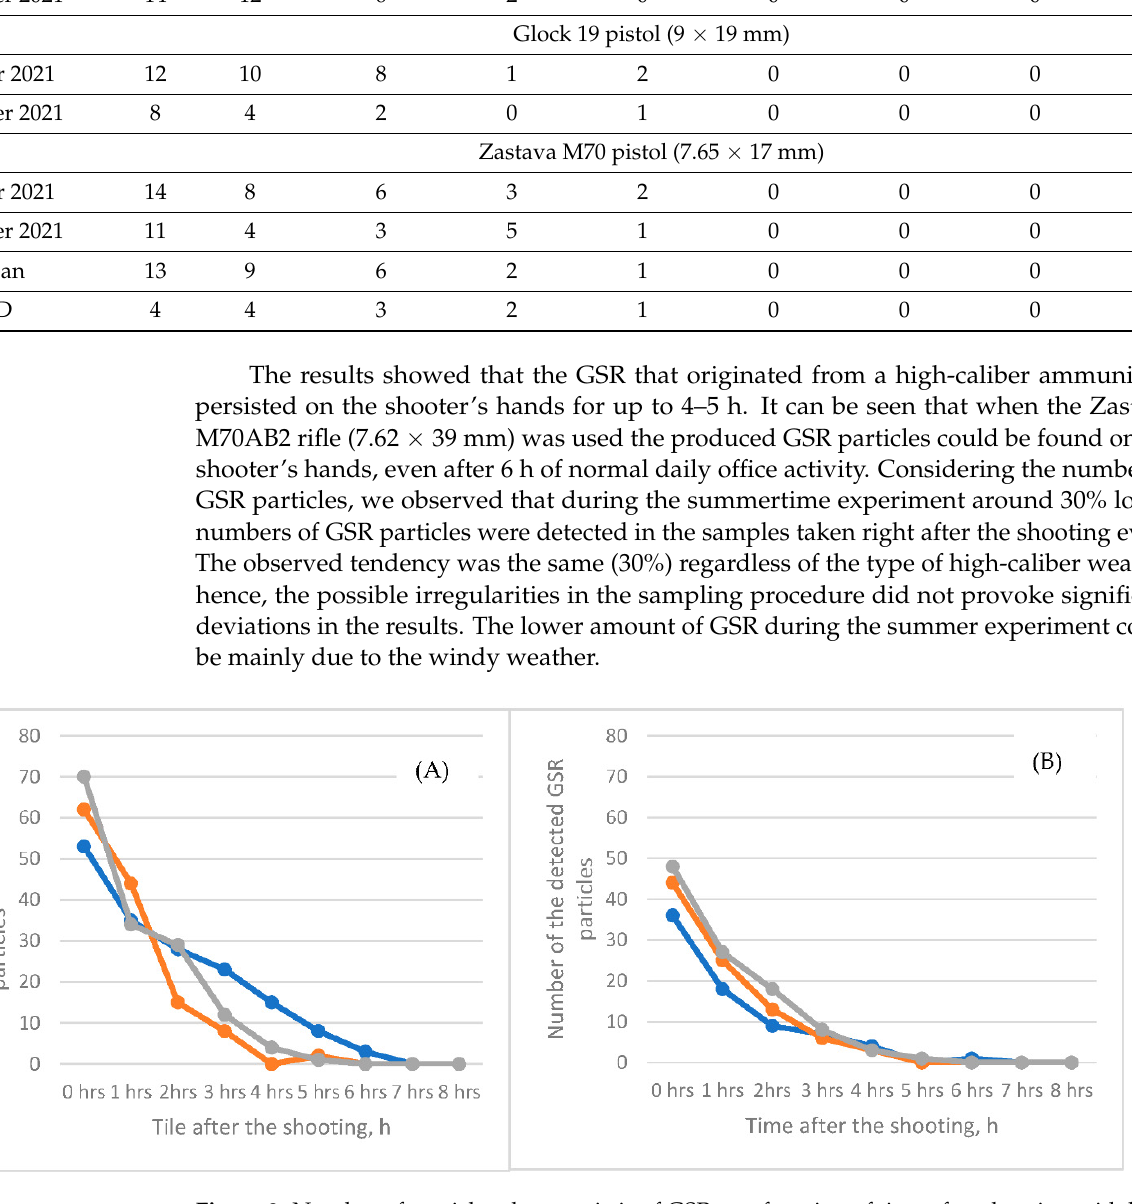
Figure 3. Number of particles characteristic of GSR as a function of time after shooting with high- caliber ammunition: Zastava M70AB2 rifle (7.62 × 39 mm) (blue line), Zastava M48 bolt-action rifle (7.92 × 57 mm) (orange line), and RPD light machine gun (7.62 × 54 mm) (grey line). The experiments were carried out during: ( A ) the winter season and ( B ) the summer season.